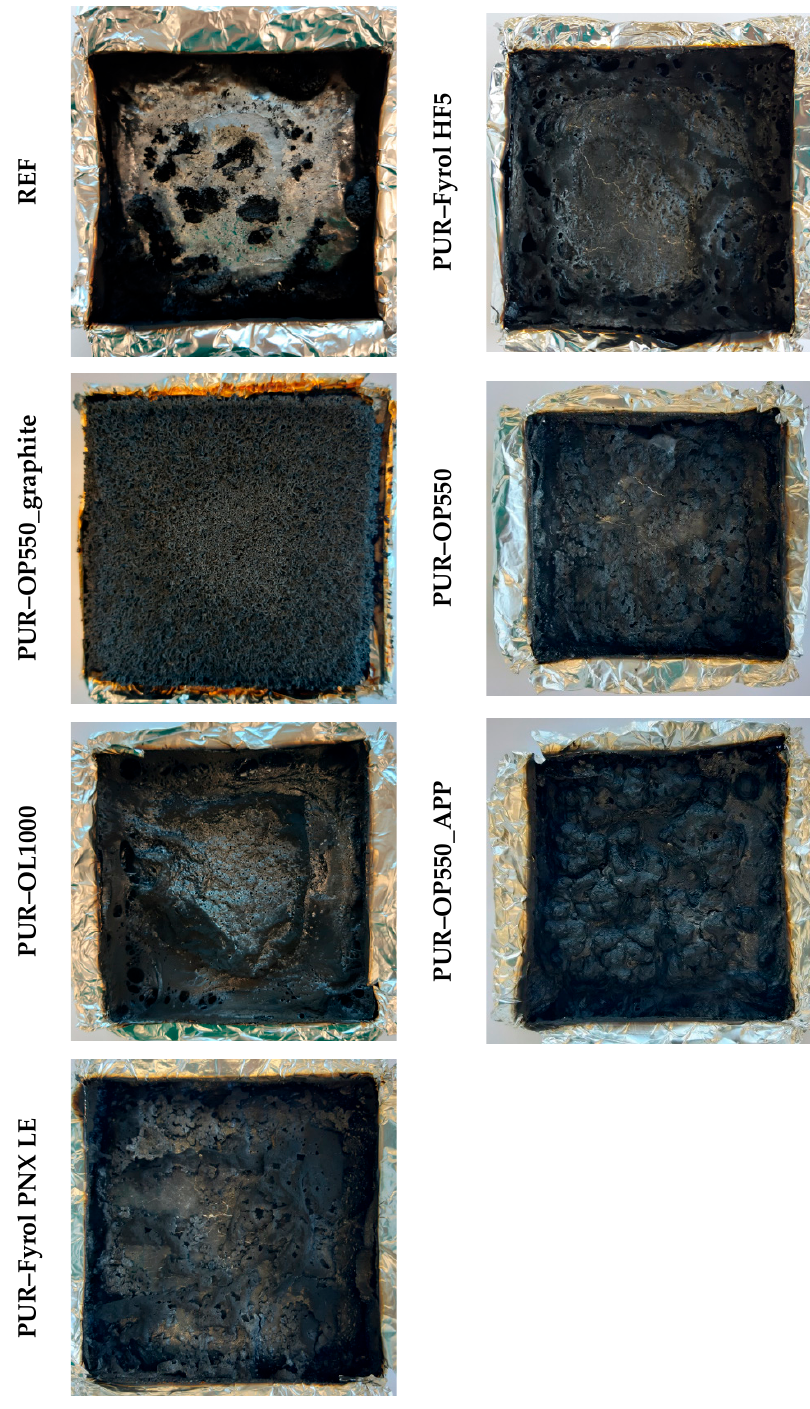
Figure 11. Foam samples after cone-calorimeter tests.